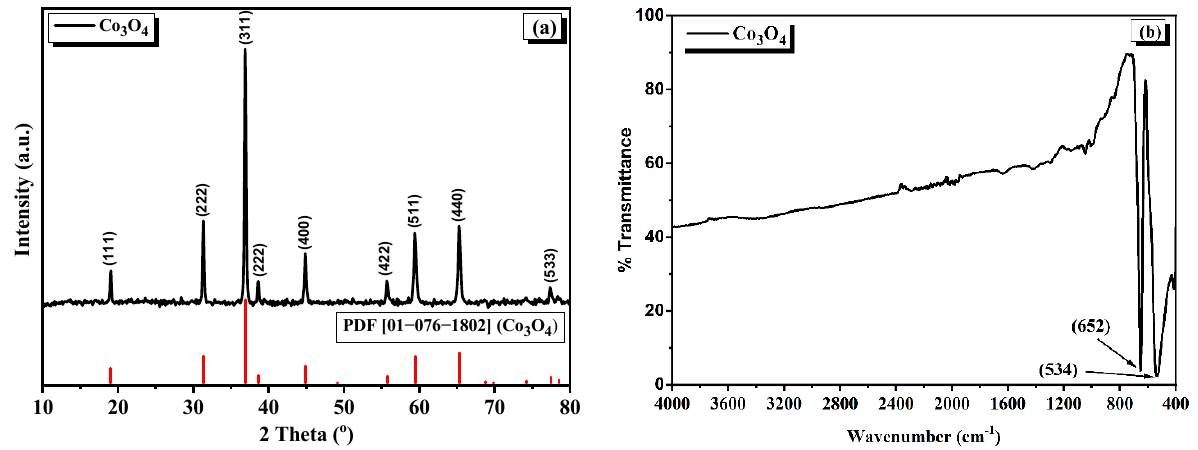
Figure 1. Powder XRD pattern ( a ) and FTIR spectrum ( b ) of Co 3 O 4 structures prepared by calcination of the as electrospun nanowires .